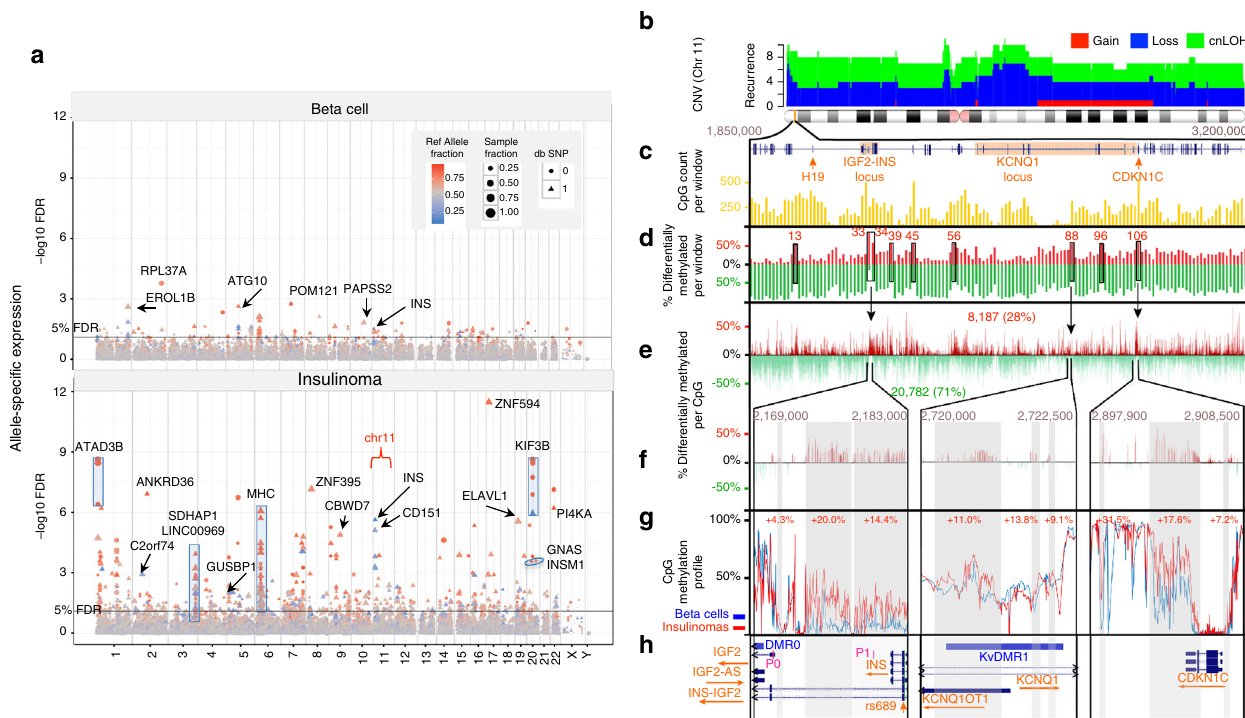
Fig. 4 Global allele-speci fi c expression and CpG methylation patterns in insulinomas and beta cells suggests a link between CNVs and ASE on the chromosome 11 imprinted locus. a A Manhattan plot of ASE shows readily apparent genome-wide differences between beta cells ( top panel ) and insulinomas ( lower panel ), suggesting broad genomic ASE abnormalities in insulinomas. Most of the differences observed are in the reference allele ( red ). However, in insulinomas there is a strong preference for ASE from the alternate allele ( blue ) in chromosome 11 near the insulin (INS) locus. b CNV analysis suggests that chromosome 11 harbors recurrent loss/cnLOH with each CNV segment recurring in an average of 8 – 9 of the 26 insulinomas. In addition, one of the most signi fi cant deleted regions identi fi ed by GISTIC2.0 analysis (Fig. 1f) is found on cytoband 11p15.5, which also contains the two imprinting control regions (ICRs). c A blow up of the 11p15.5-15.4 imprinted region that underwent DNA methylation analysis, highlighting key 11p15 genes and showing the density of the 29,675 CpGs in the 1.35 Mbp, in 135 windows of 10Kbp. CpG density in the region in bins of 10 kb. d A comparison of methylation patterns between insulinomas ( n = 10) and FACS-sorted beta cells ( n = 2), in the same 10 kb windows as in c . Insulinomas display at least nine hypermethylated windows ( red ) denoted W13-106. Note also the broad hypomethylation ( green ) in this region. In all, 70.4% of CpGs were hypomethylated and 27.7% hypermethylated, with 1.9% showing no differential methylation. e Expanded view showing the relative methylation of the 29,675 CpG in the 11p15 region, highlighting four windows (W33, 34, 88,106) with the greatest relative hypermethylation in insulinomas. f Further expansion of the three hypermethylated regions in e delineating individual hypermethylated CpGs. The gray shaded areas highlight the hypermethylated regions. g The average CpG methylation status of each of the CpGs in the three regions in insulinomas ( red ) vs. beta cells ( blue ). h Genome browser view of the three highlighted 11p15 regions, highlighting the genes and regions affected by the hypermethylated CpGs in the insulinomas, including IGF2, INS-IGF2, IGF2-AS, KCNQ1, KCNQ1OT , the imprinting control region KvDMR, and